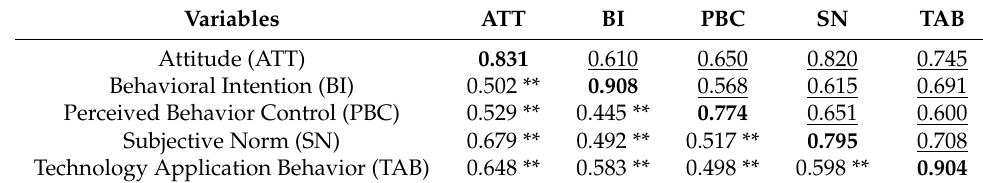
Table 5. Discriminant validity—Fornell–Larcker Criterion and Heterotrait–Monotrait Ratio.